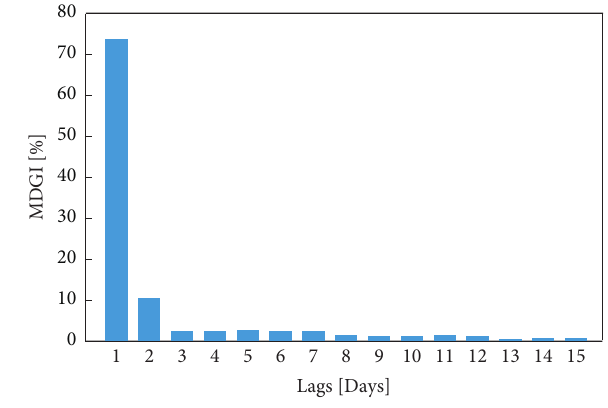
Figure 2: MDGI ranks of 10